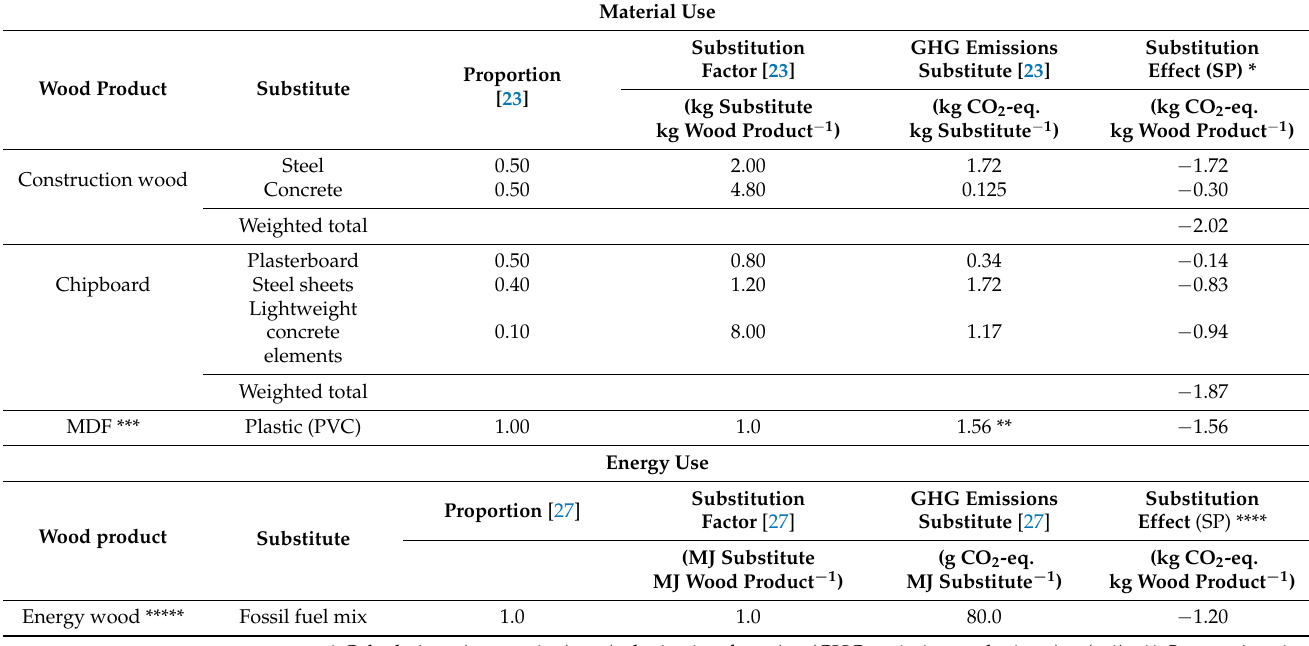
Table 5. Potential substitution effects of wood